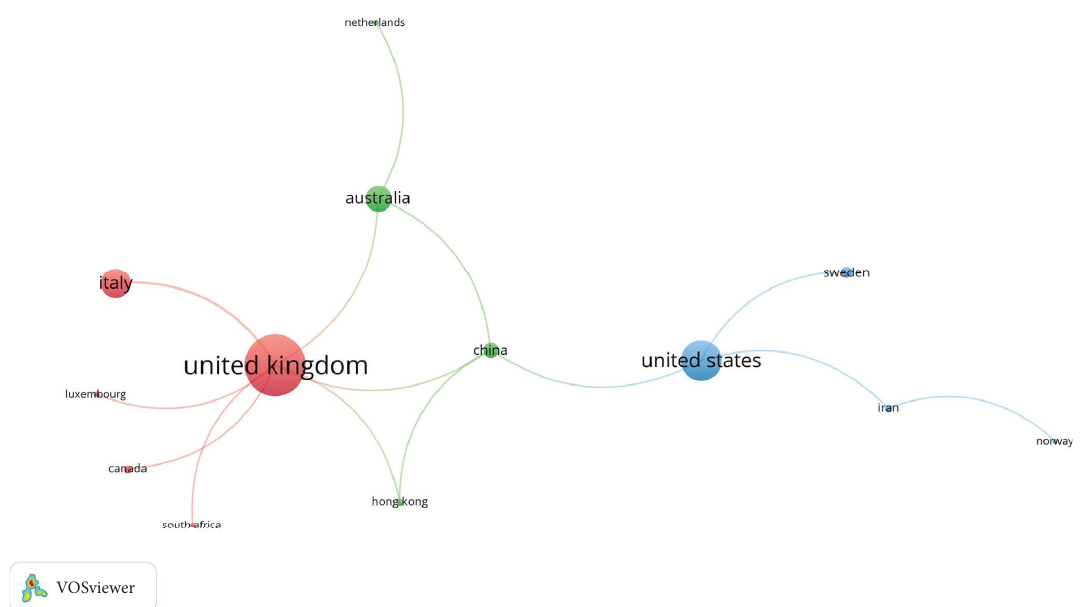
Figure 7: Countries making important contributions to the Digital Twin research in the AEC-FM